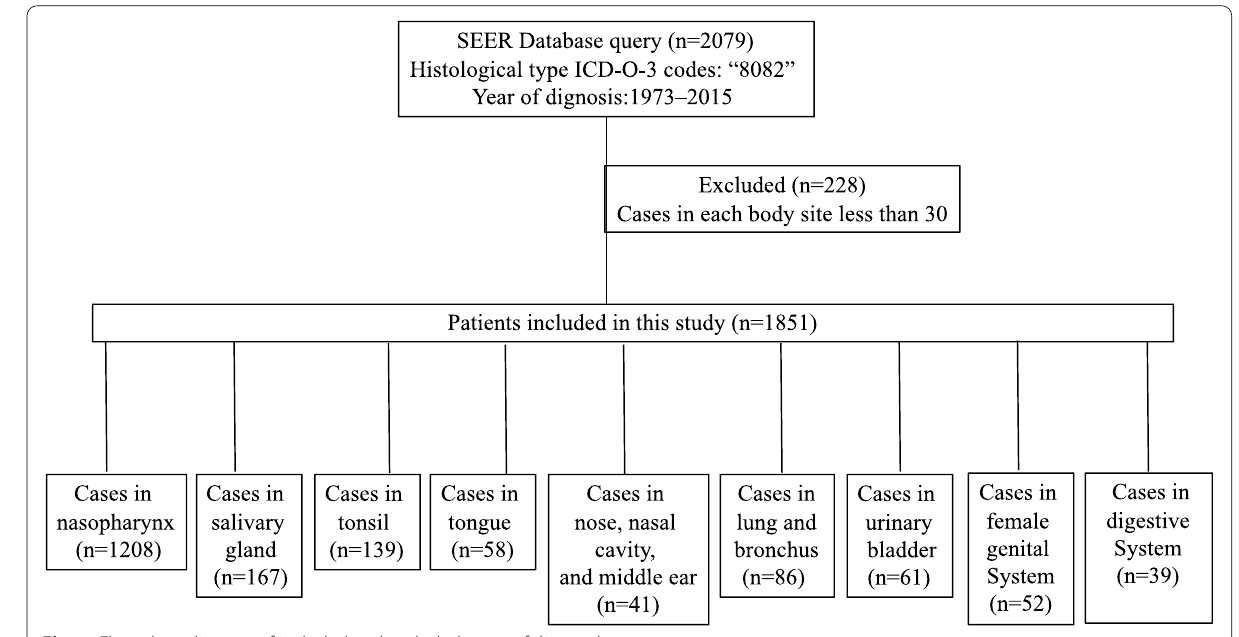
Fig. 1 Flow chart diagram of included and excluded cases of this